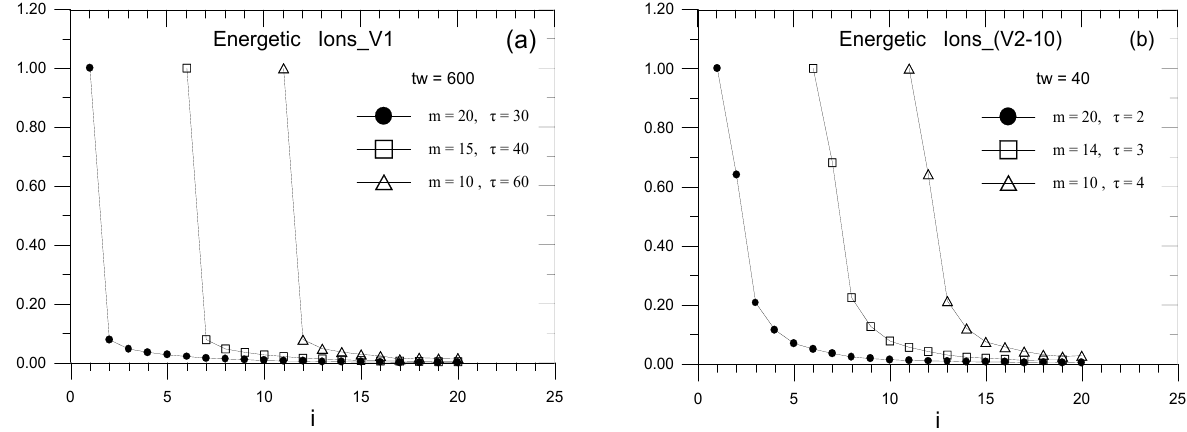
Figure 14 Fig. 14. (a, b) The spectra of singular values σ i , with parameter m = 10 , 15 , 20, estimated for the SVD reconstructed components V 1 , V 2 −